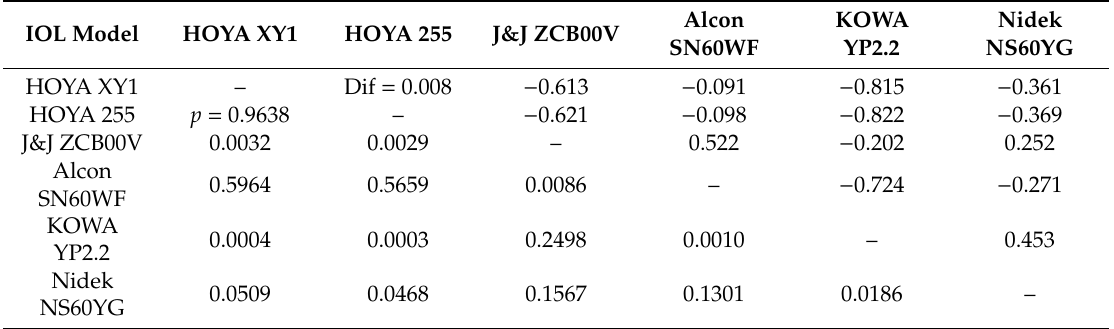
Table 3. Difference in forces required for anterior IOL displacement among the various IOL models.